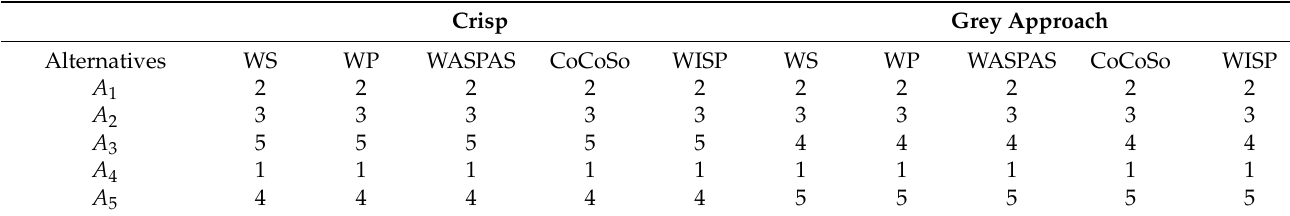
Table 20. Ranking orders of alternatives obtained on the basis of 150 virtual respondents.